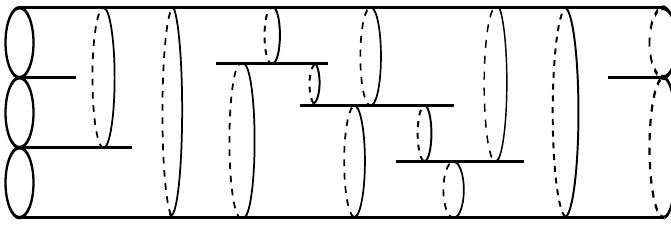
Figure 2 . A Feynman diagram of